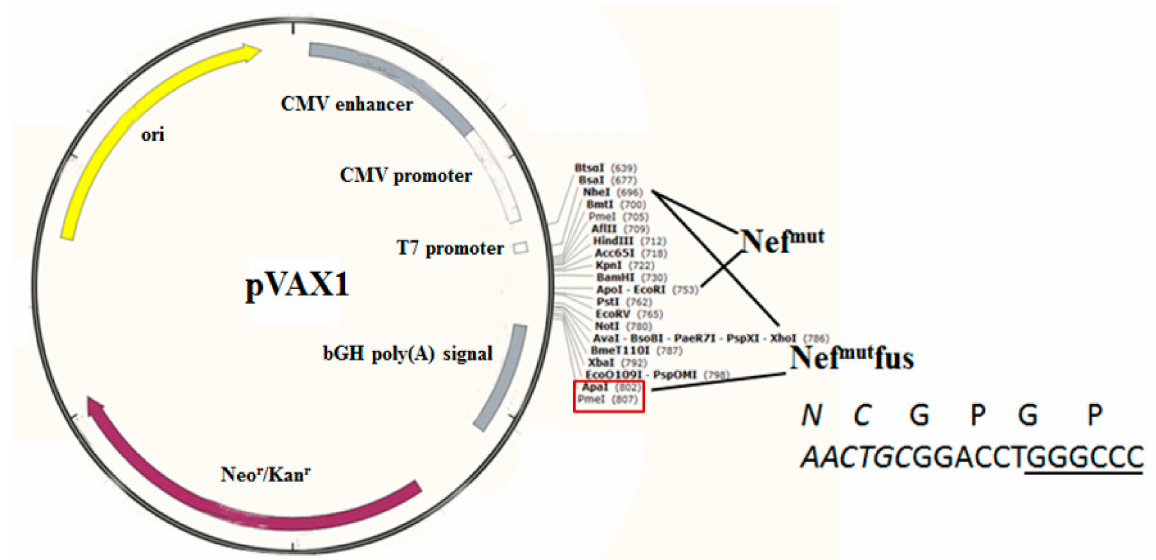
Figure 1. Map of vectors expressing SARS-CoV-2-based fusion proteins. Shown are the map of pVAX1 vector as well as the cloning strategies pursued to obtain both pVAX1-Nef mut and pVAX1-Nef mut fusion vectors. Restriction sites where the SARS-CoV-2 ORFs were inserted are highlighted in the red box. On the bottom right, shown are both amino acid and nucleotide sequences of Nef mut C-terminus in the pVAX1-Nef mut fusion vector (in italics), as well as of the GPGP linker overlapping the Apa I restriction site (underlined sequence).